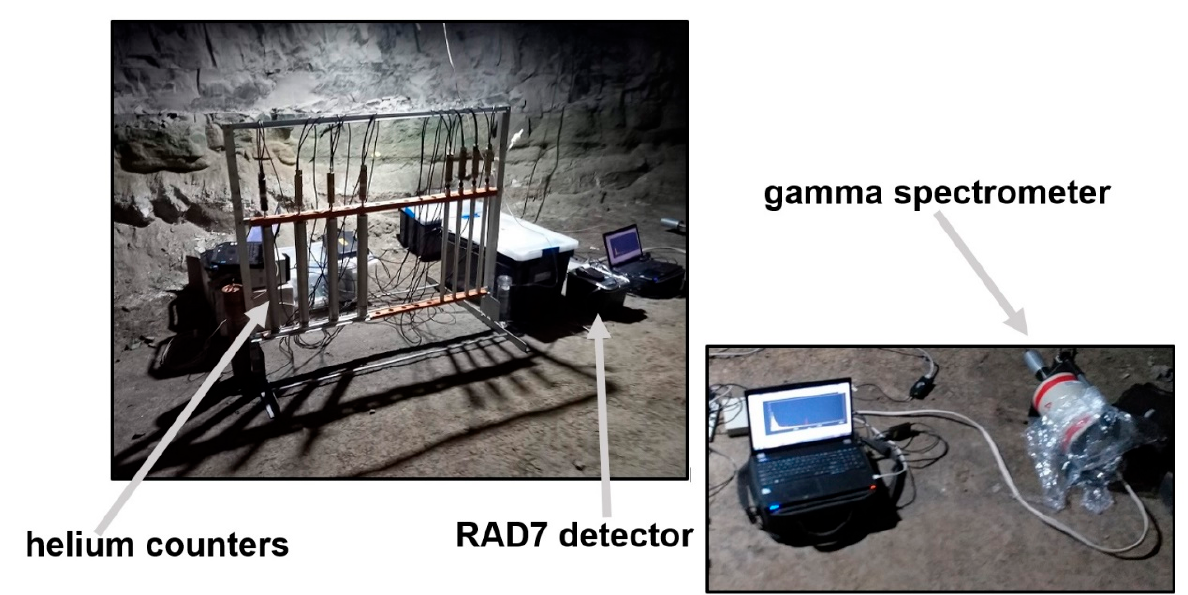
Figure 4. Measurement setup used during the measurements: helium counters; radon monitor RAD7 and HPGe spectrometer.